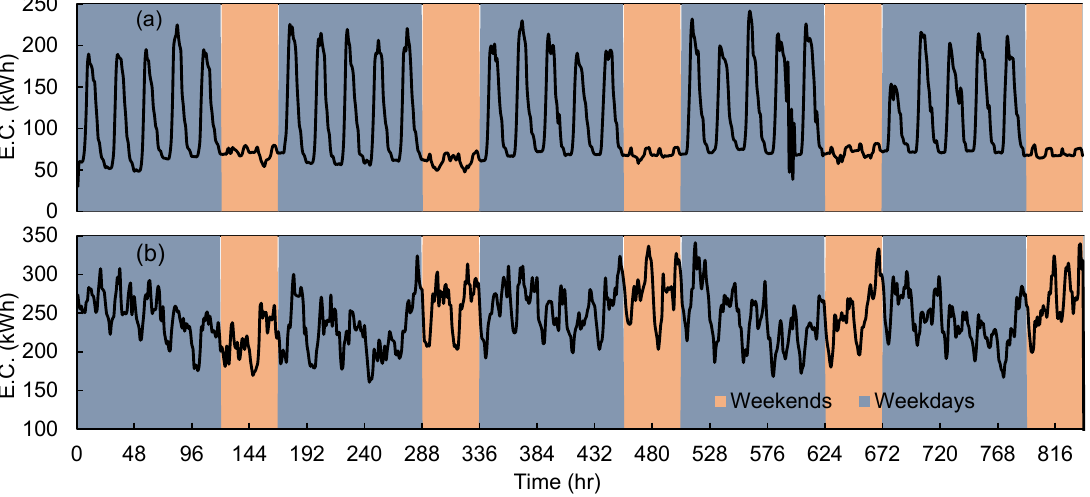
Figure 2. Building electricity consumption of ( a ) a school; ( b ) a hotel. Reproduced from Ahmad et al. [3], 2017.